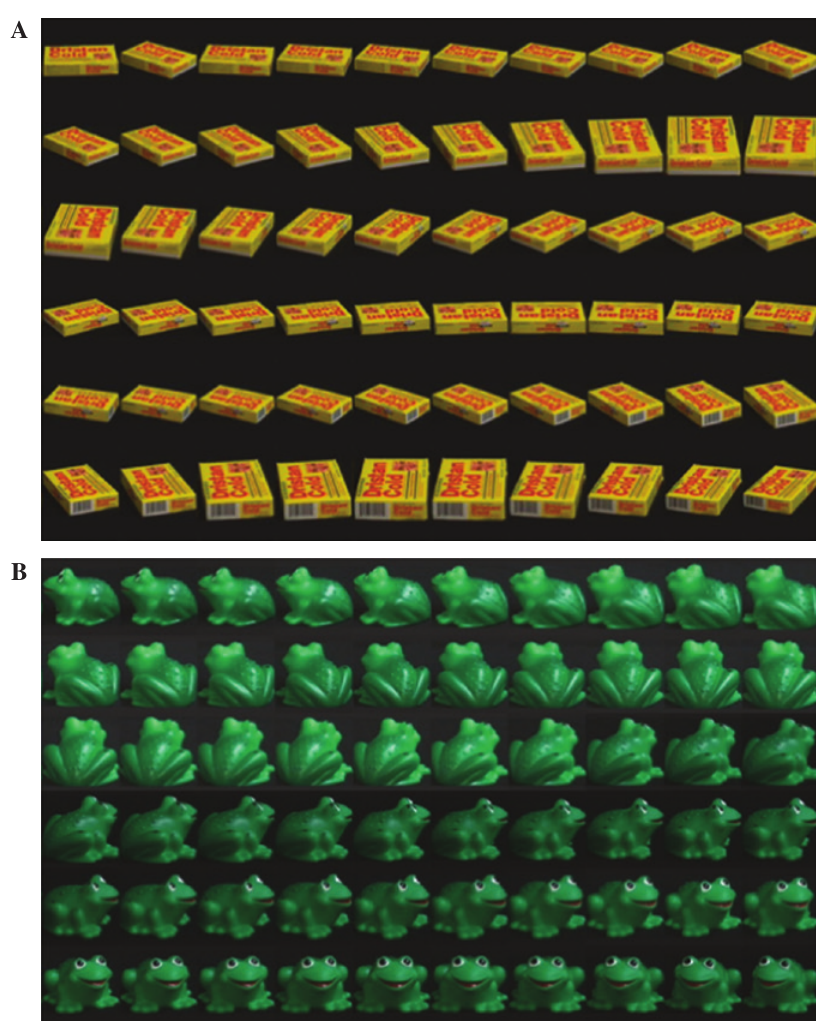
Figure 6: Sixty Different Orientations of